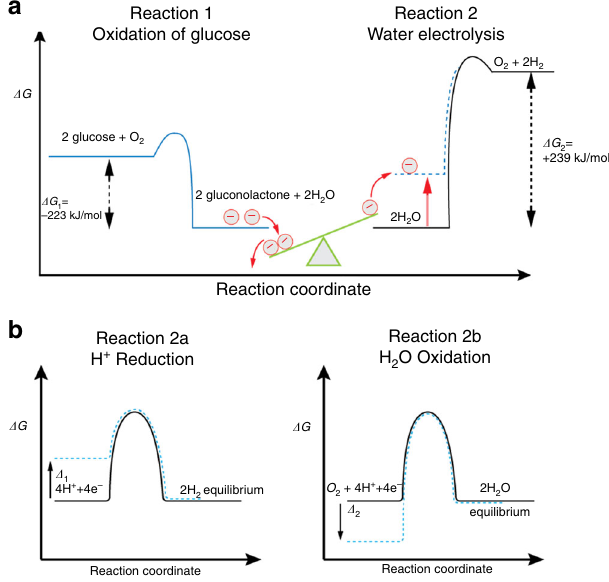
Fig. 1 Energetics of the uphill reaction principle. a The exergonic glucose oxidation does not provide enough energy to directly drive the electrolysis of water, because the difference in Δ G of the two reactions is positive. Using the electrons liberated by the oxidation of multiple glucose molecules allows one to raise the potential of a fraction of these electrons that acquire suf fi cient energy for the electrolysis of water. b The energy provided by reaction 1 is used to promote electrons to a more negative potential (more positive Δ G ) compared to equilibrium (black line) at the electrolyser cathode by a value Δ 1 (blue dashed line) allowing the proton reduction (reaction 2a) to proceed. On the other hand, the potential at the electrolyser anode (reaction 2b) is changed to a more positive value (more negative Δ G ) with respect to equilibrium (black line) by a value Δ 2 (blue dashed line). This allows the global reaction 2 to occur because the sum of − Δ Δ 1 and 2 is higher than the initially missing 16 kJ mol